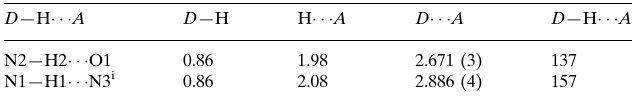
Hydrogen-bond geometry (A˚ , (cid:1)